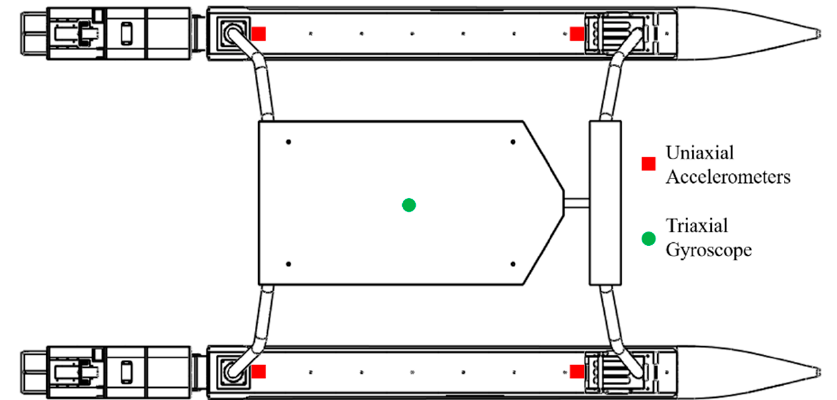
Figure 8. Diagram of the sensor arrangement.